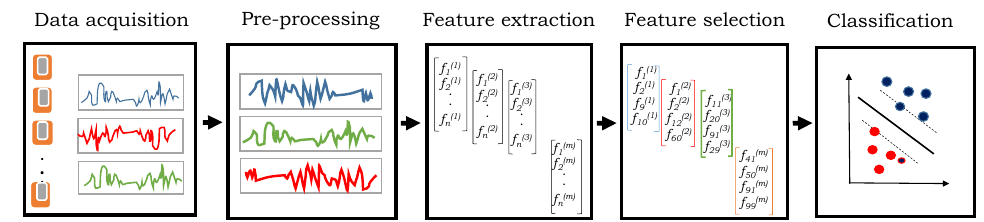
Figure 2. Different steps to recognize human activities from raw sensory